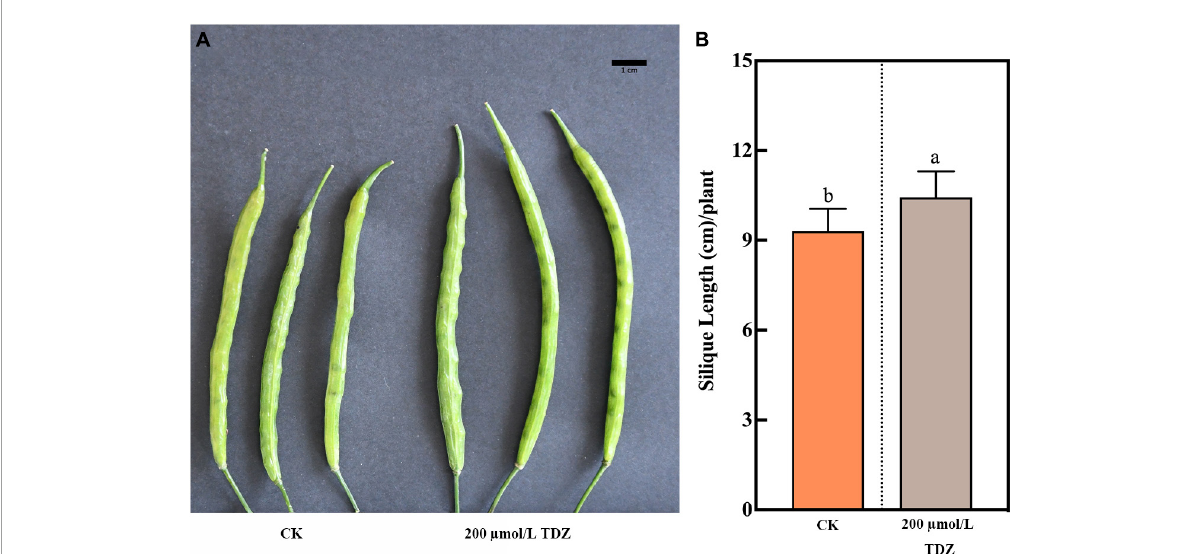
( Figure 1B ). The effect of different concentrations of TDZ on the seed size of B. napus at 40th day after full maturity